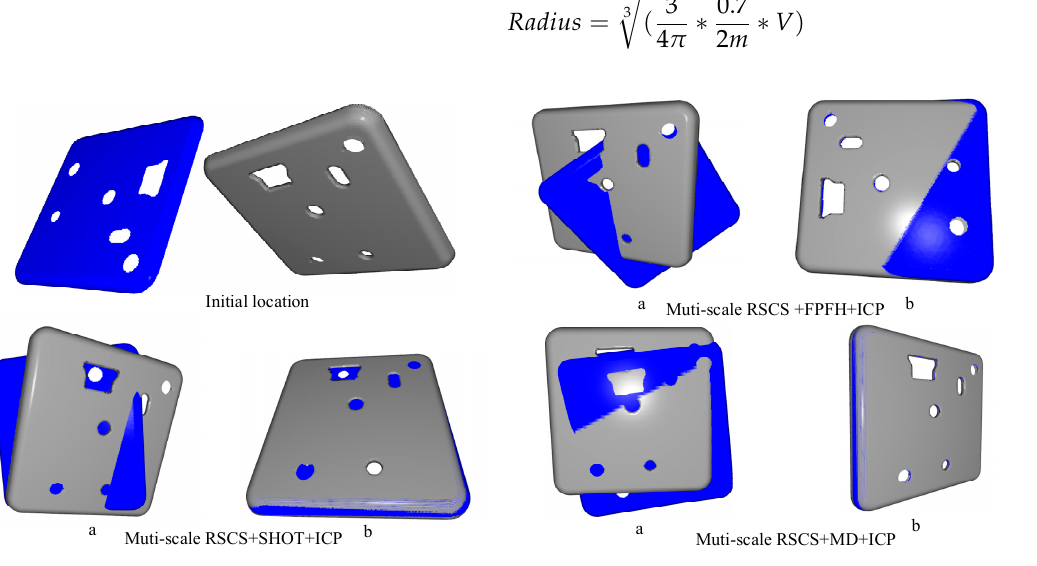
Figure 15. Results of different registration schemes for part 1: ( a ) coarse registration; ( b ) fine regis- tration.